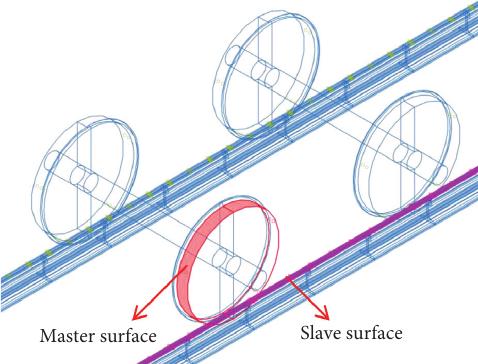
Figure 7: Wheel-rail contact